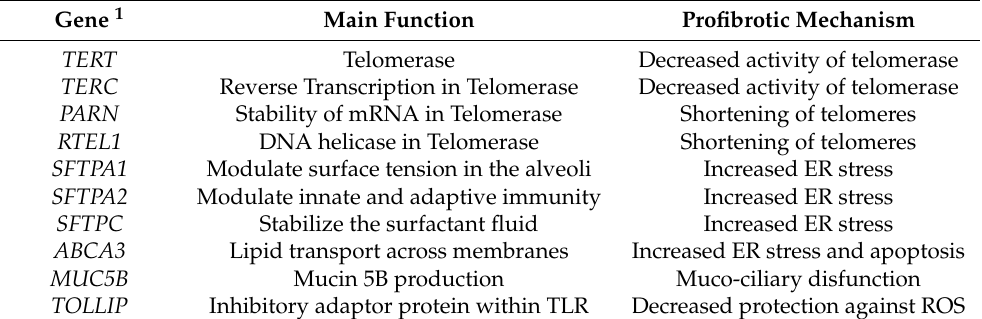
Table 2. Genes described in idiopathic pulmonary fibrosis (IPF) and familial pulmonary fibrosis (FPF) and their profibrotic mechanisms.